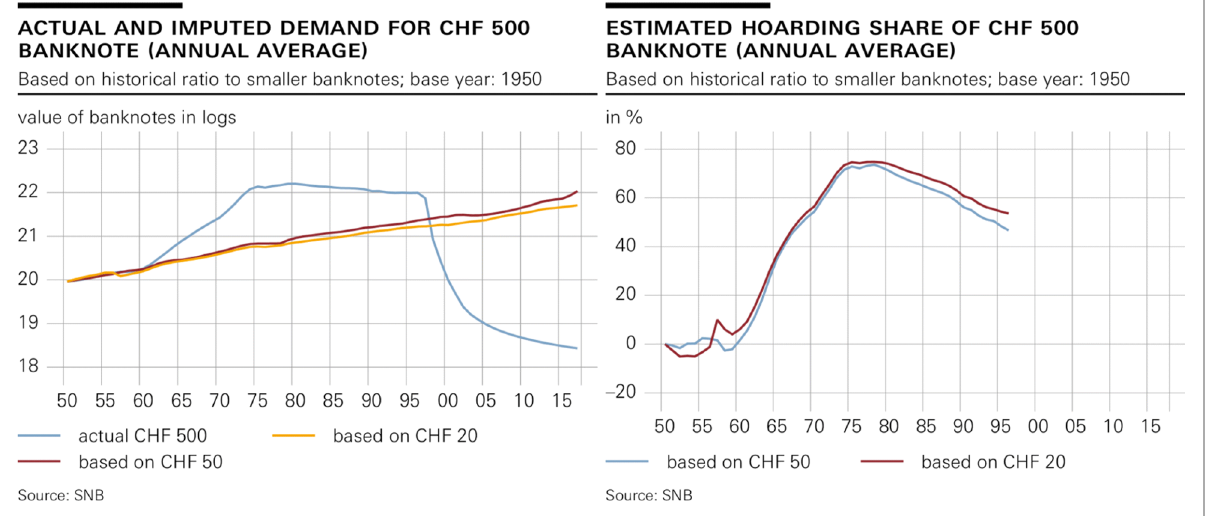
Fig. 3 Method based on ratios - results for CHF 500